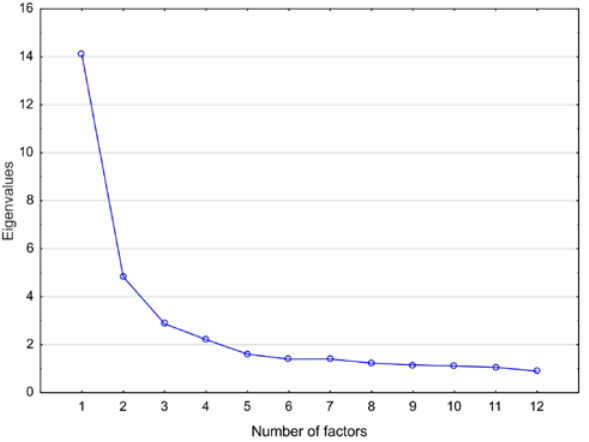
Figure 1: Plot of